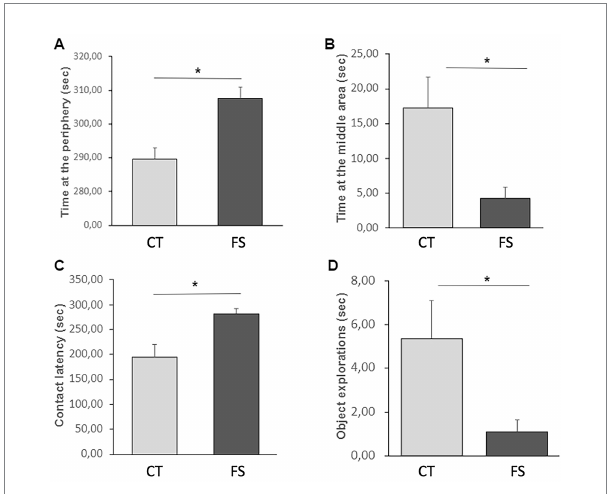
FIGURE 2 Behavioral comparisons in the NSO between animals fed with a control feed (CT, n = 12) and animals fed with a feed supplemented with the functional ingredient (FS, n = 12). FS animals spent more time than CT animals at the periphery of the test arena (A) and less time in the middle area (B) where the object was suspended. They also presented a higher contact latency (C) with the object and explored it less than CT (D) . Mean ± SD, two-way ANOVA, * p <